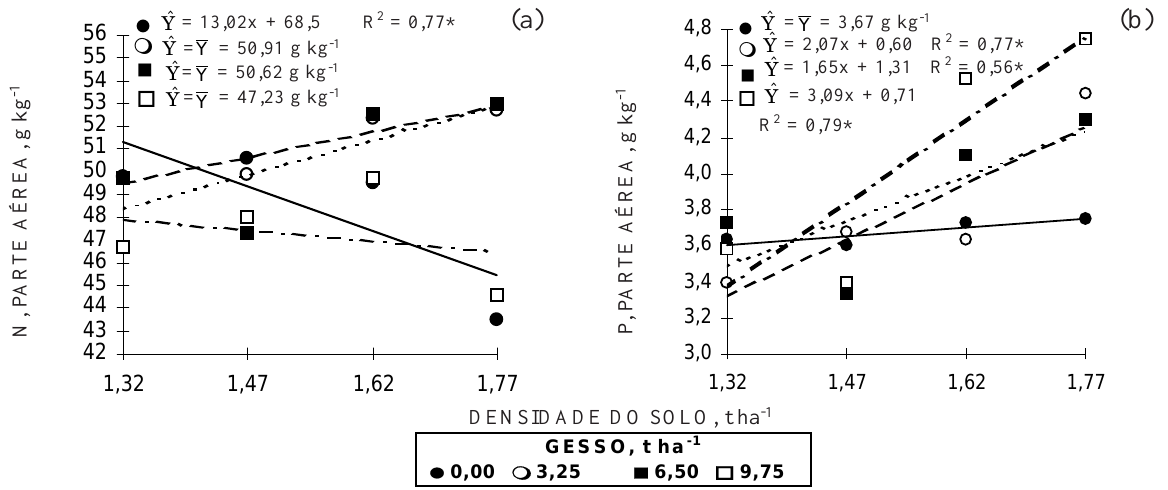
Figura 3. Quantidades de N (a) e de P (b) na parte aérea da soja, em função da densidade do solo do anel central da coluna, dentro de cada dose de gesso